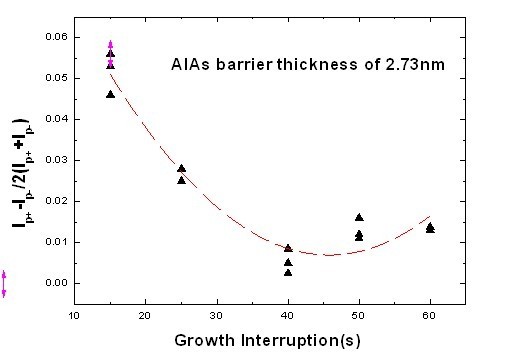
I-V asymmetry dependence on growth interruption. I-V asymmetry dependence on growth interruption at the AlAs/In0.53Ga0.47As interfaces with an AlAs barrier thickness of 2.73 nm.